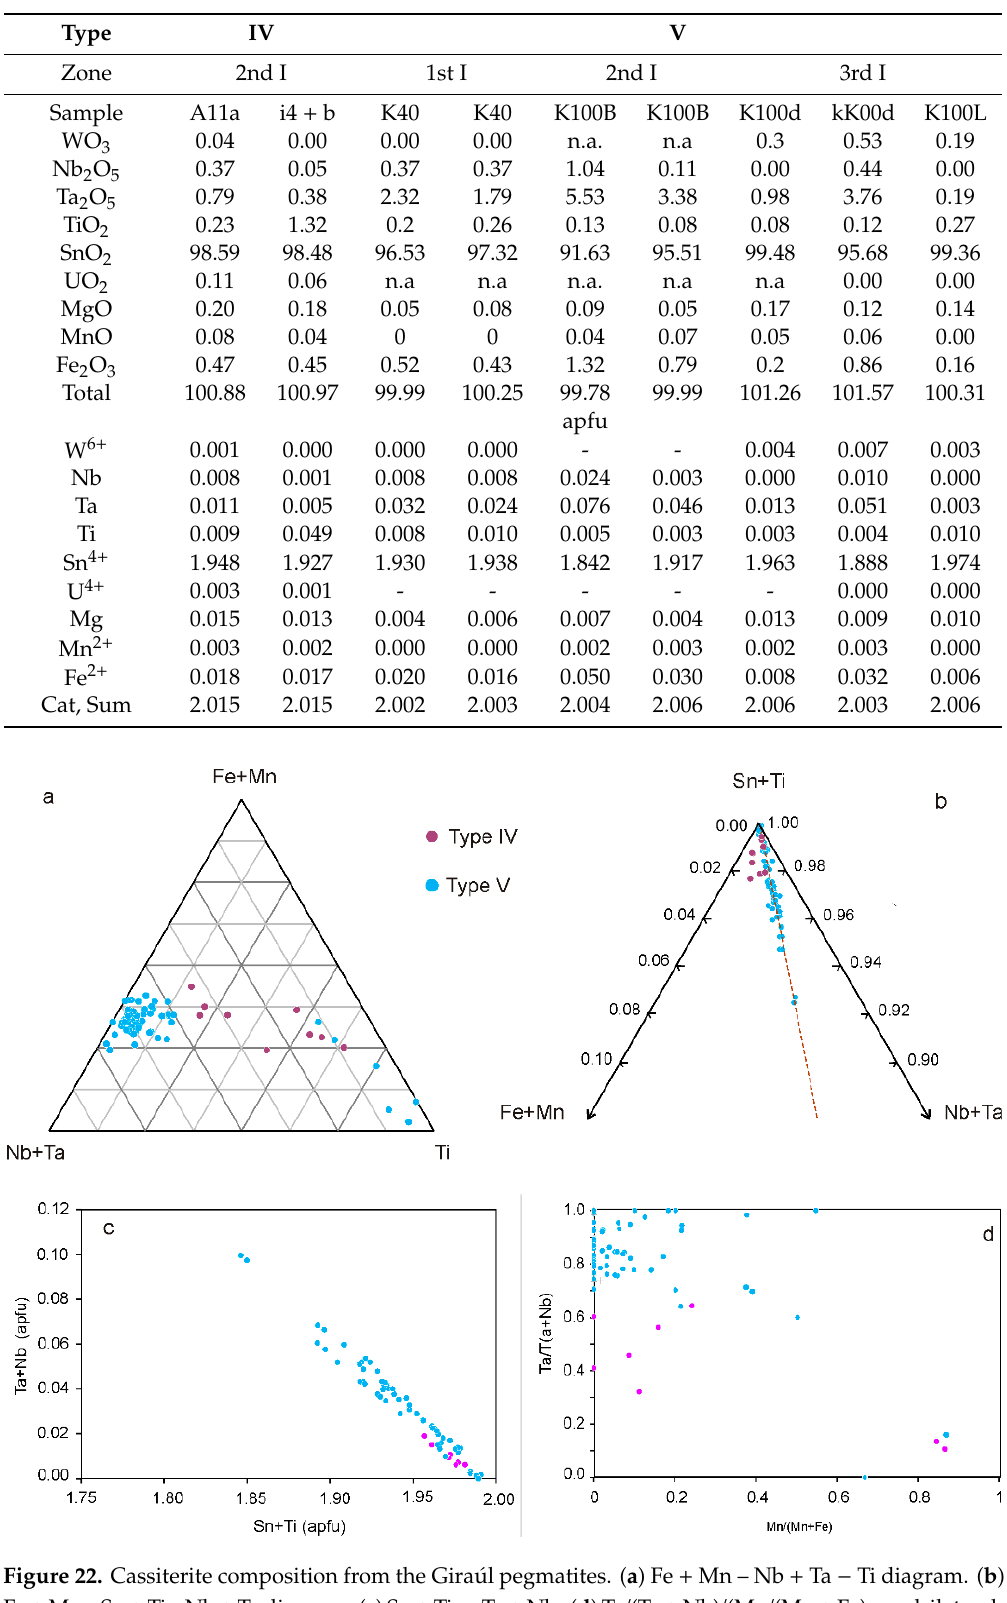
Table 5. Representative chemical composition (wt.%) of cassiterite from the Giraúl pegmatites.